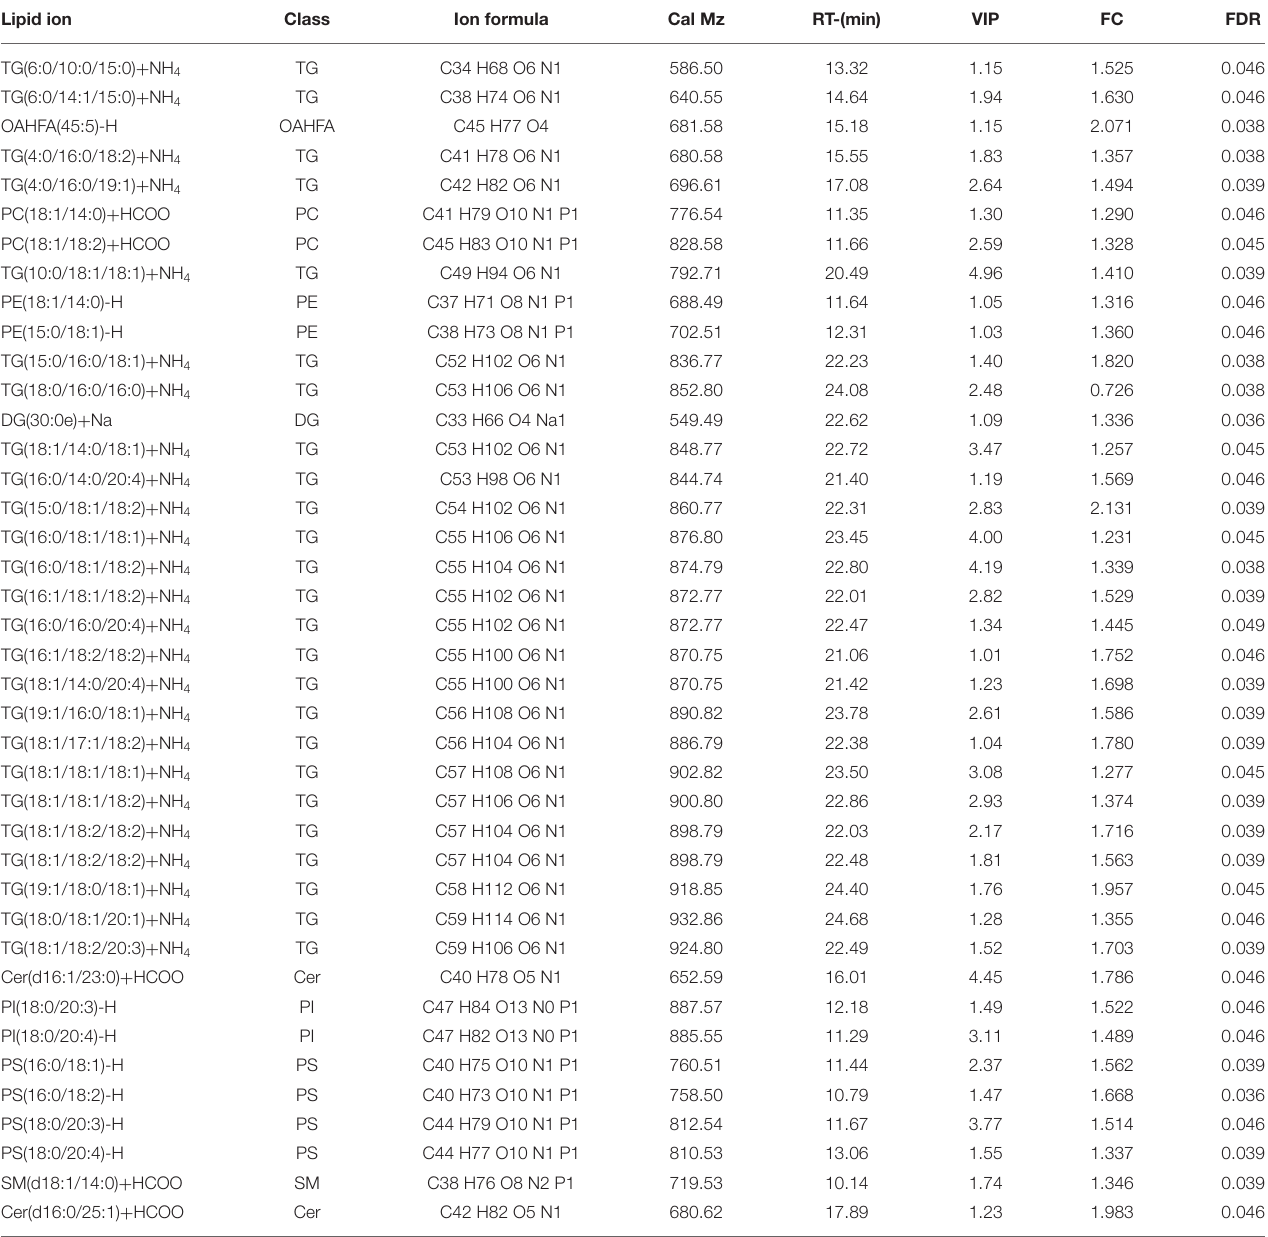
TABLE 5 | Differences in lipid metabolites content between the CTR and EUL groups ( n = 10, CTR and n = 8, EUL). Lipid ion Class Ion